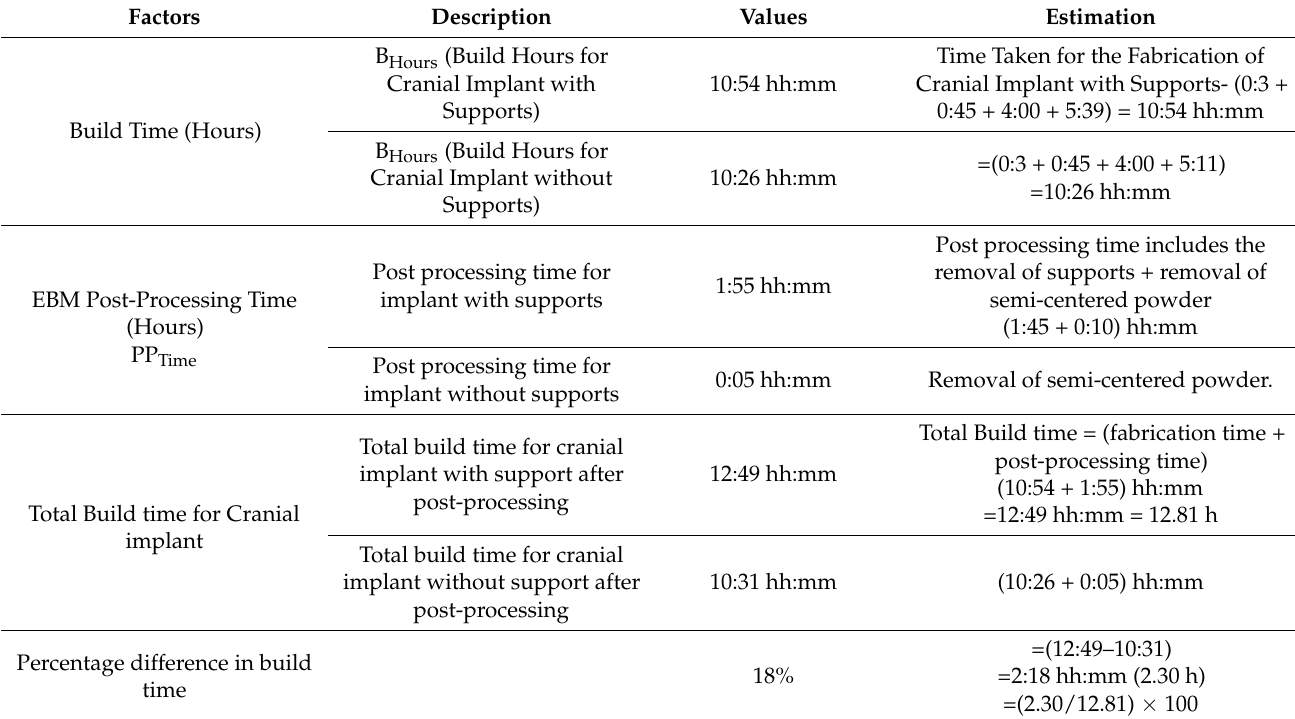
Table 2. Time analysis for fabrication of cranial implant with and without